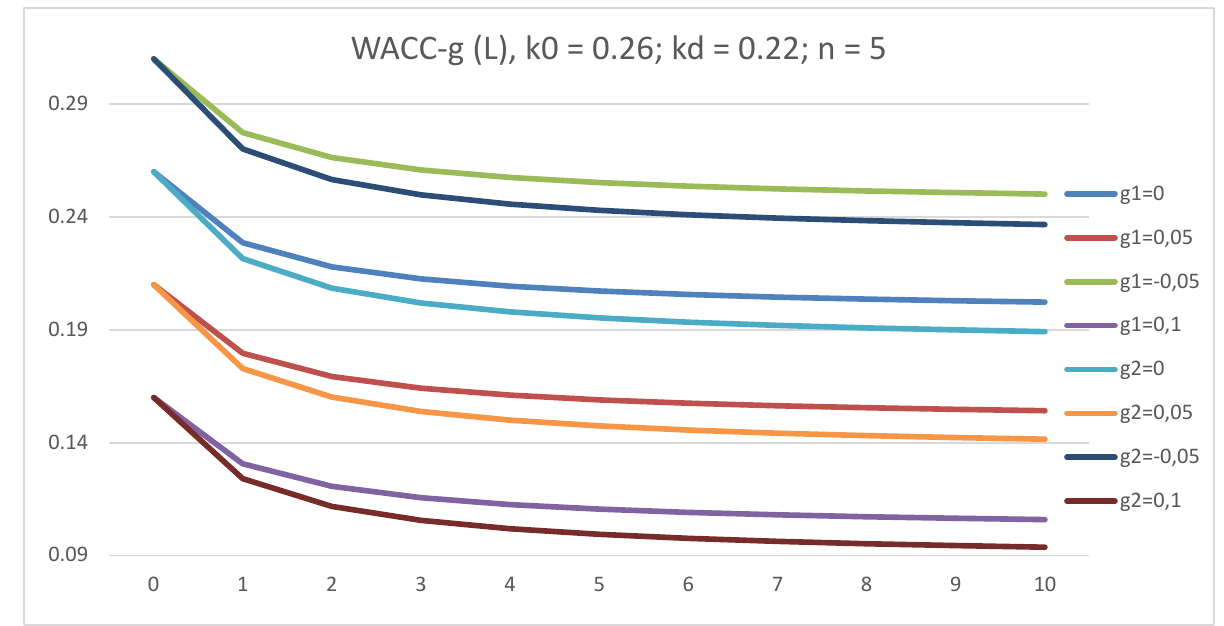
Figure 2. The dependence of discount rate, WACC–g, on leverage level, L, in GBFO theory with payments of tax on profit at the end of periods (1) and as advance payments (2) at k 0 = 0.26; k d = 0.22; t = 0.2; g = 0.1; 0.05; 0.0; − 0.05, for a five-year company.